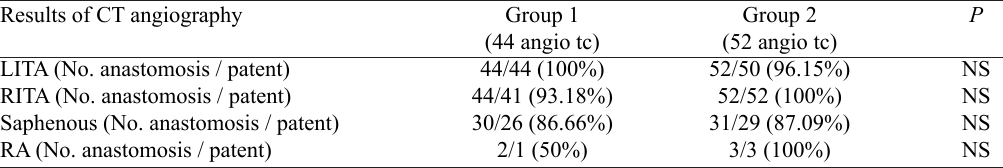
Table 3. Results of coronary CT angiography. We compute the moderate, significant obstructive lesions or occlusions. Results of CT